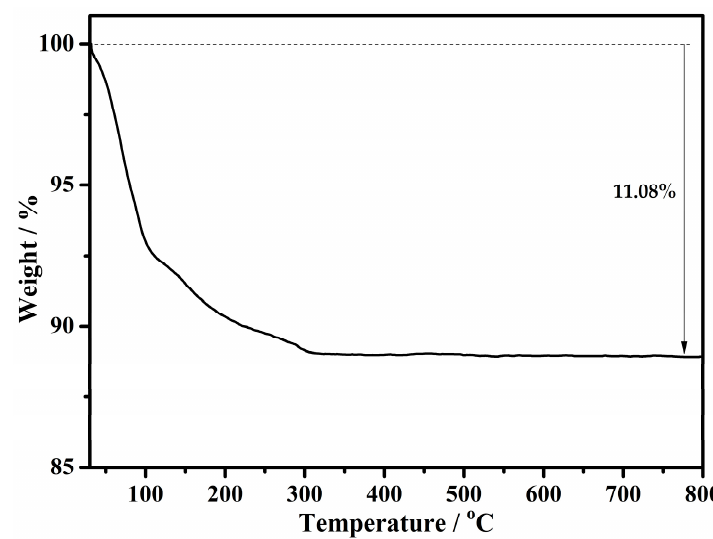
Figure 6. TG curve of compound 1 .